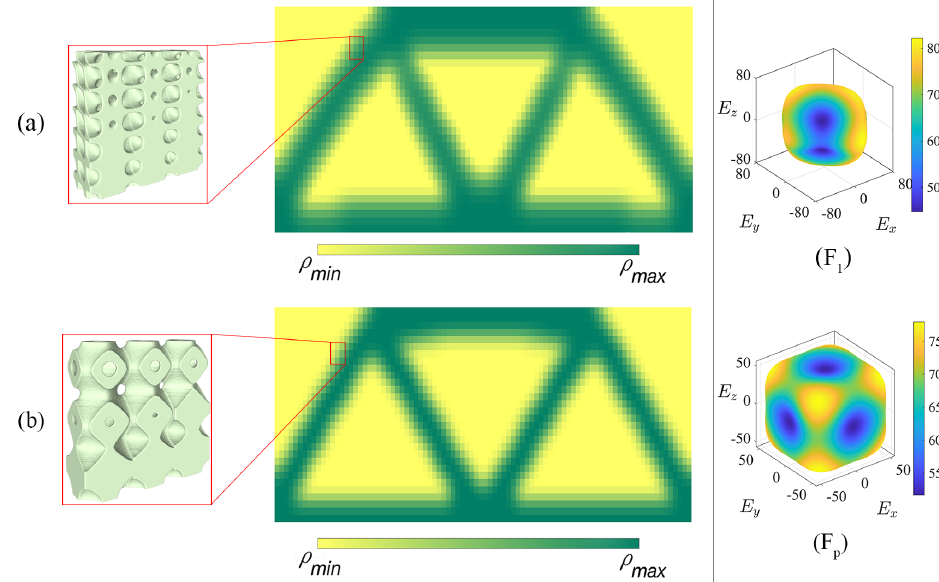
Figure 9. Density distribution of ( a ) orthotropic cellular material, and ( b ) isotropic cellular material in benchmark Case I . Right column represents the effective Young’s modulus surface for each one of the microstructures.